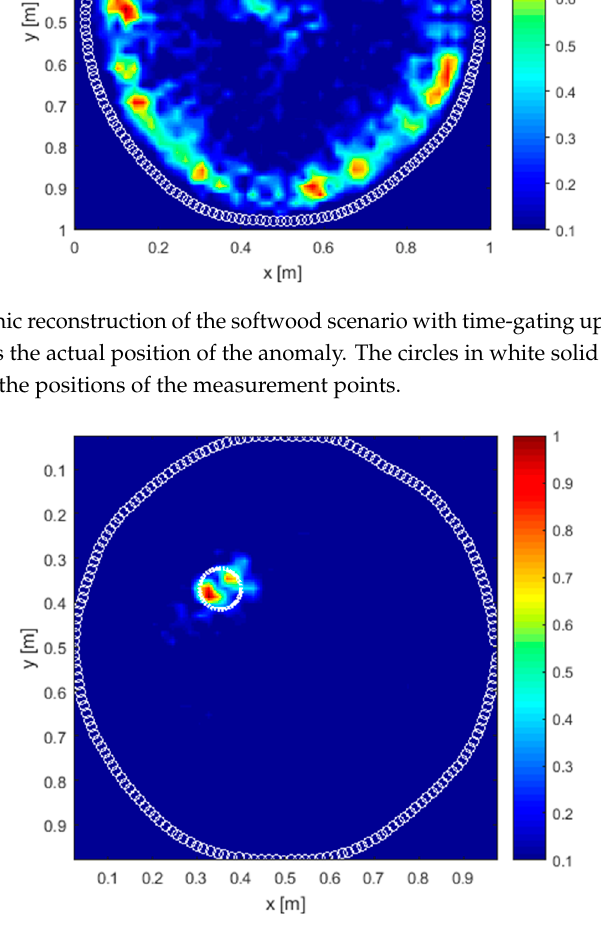
Figure 8. Tomographic reconstruction of the softwood scenario with time-gating up to 6 ns. The dashed white circle indicates the actual position of the anomaly. The circles in white solid line along the trunk perimeter represent the positions of the measurement points.